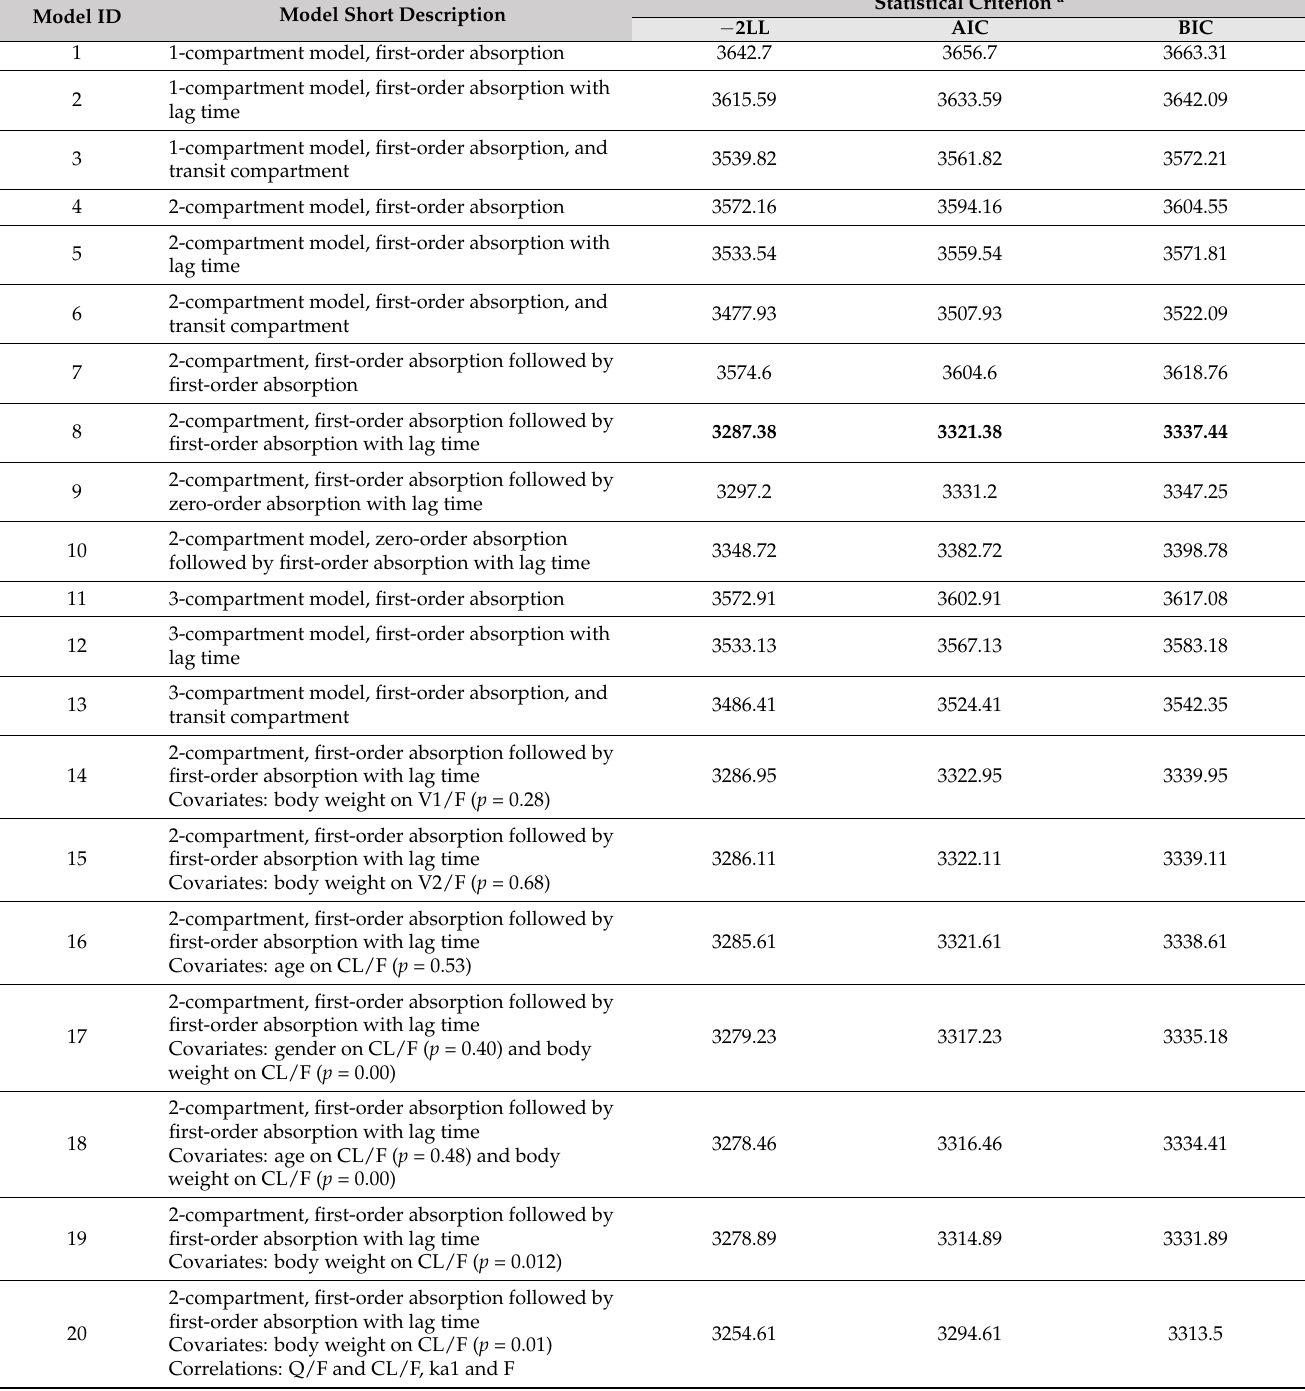
Table 1. The development path of the model of amisulpride. Only a few of the most important models are shown among the many that have been